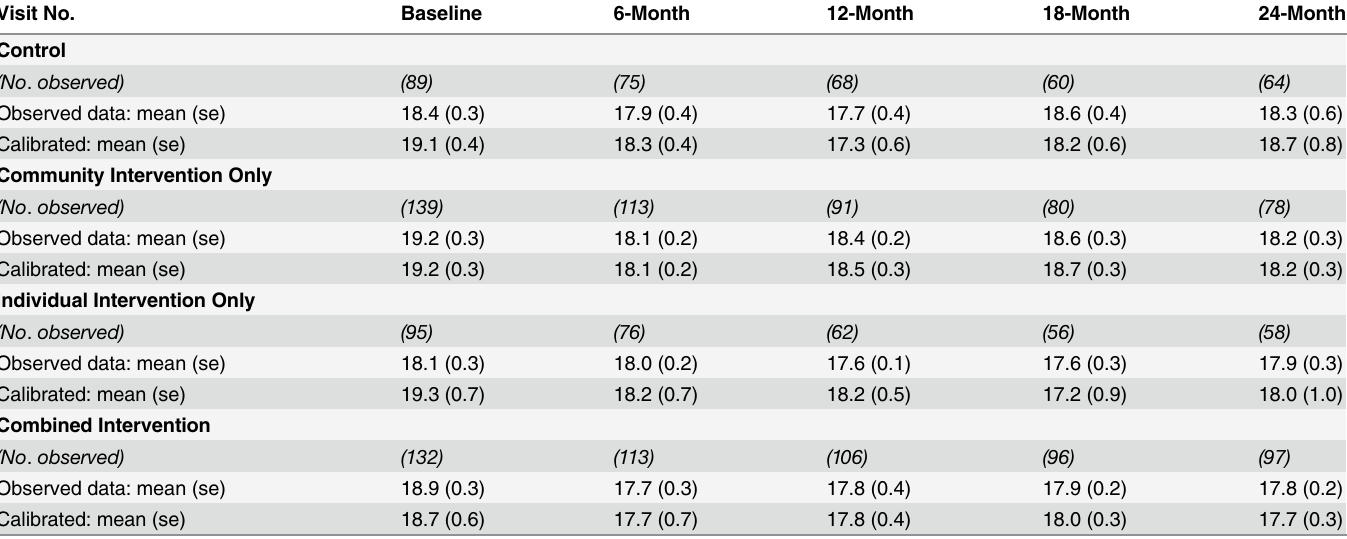
Table 6. Mean and standard error (se) of IDU stigma score among index participants. Visit